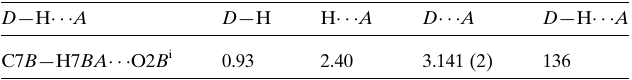
Table 1 Hydrogen-bond geometry (A˚ , (cid:2) ).